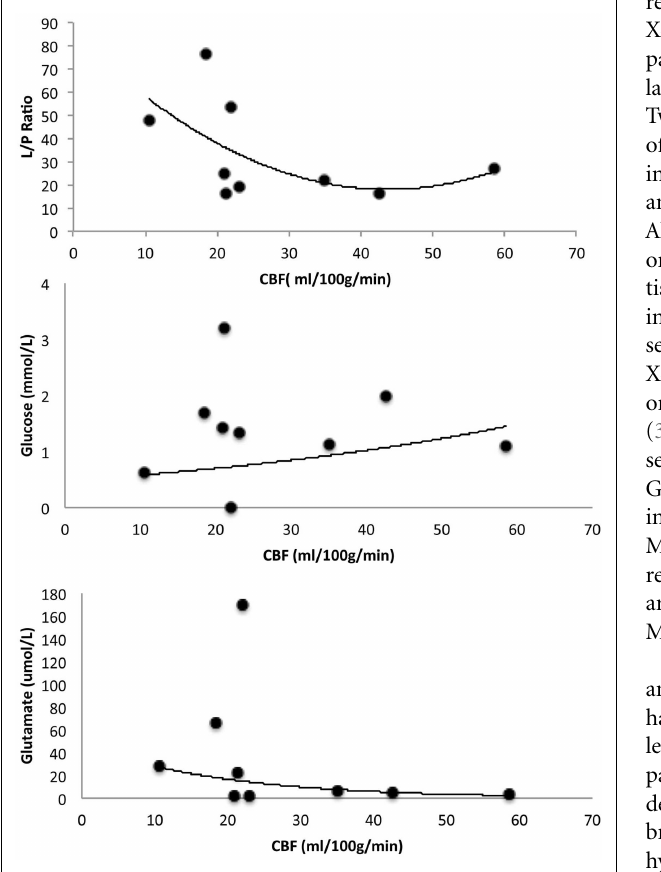
FIGURE 5 | Illustrates correlation between microdialyzate lactate/pyruvate (L/P) ratio and CBF, glucose and CBF, and glutamate and CBF .The CBF values represent the area surrounding the microdialysis